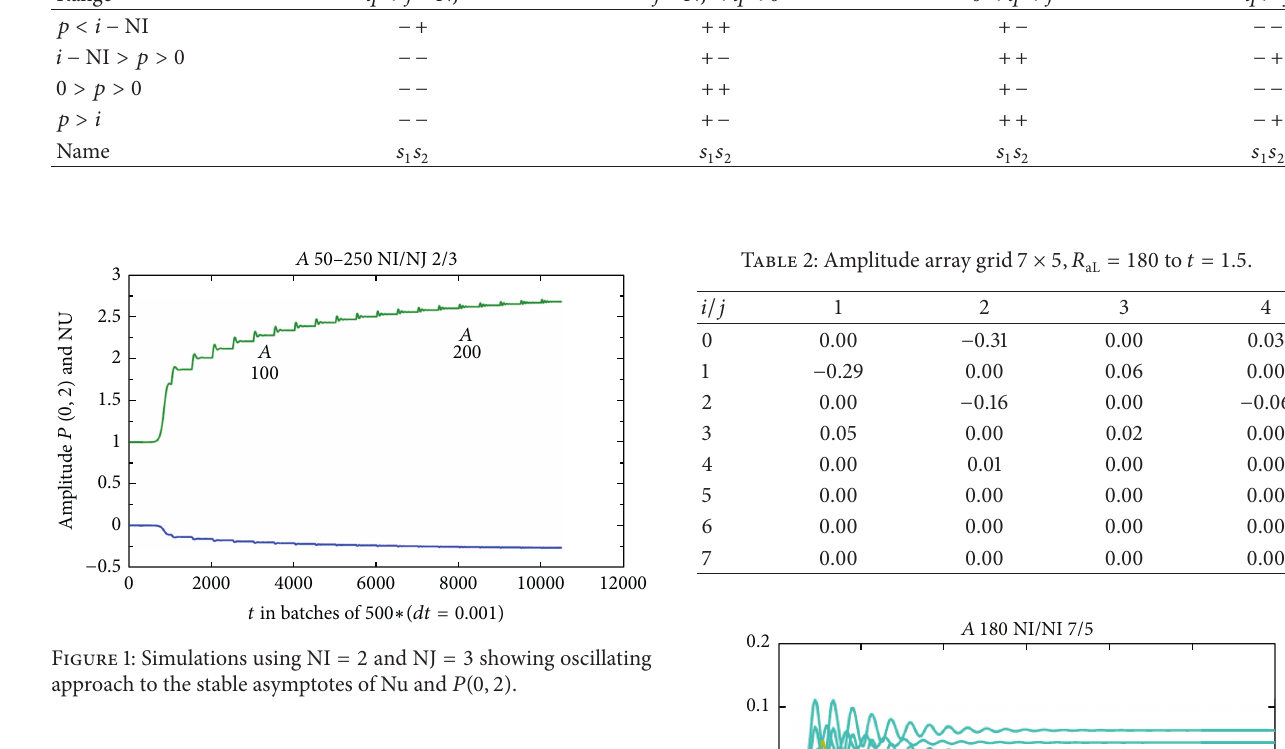
= 165 aL = 180 ; see Figure 5. The aL = 165 is shown in Table aL